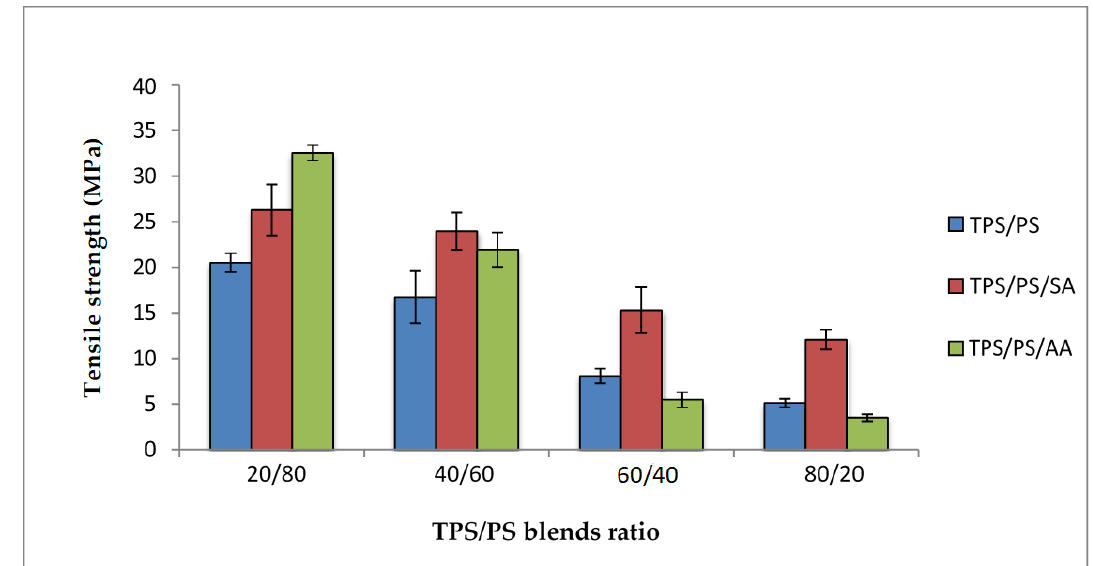
Figure 4. Tensile strength of treated TPS/PS with AA and SA at different blend ratios.